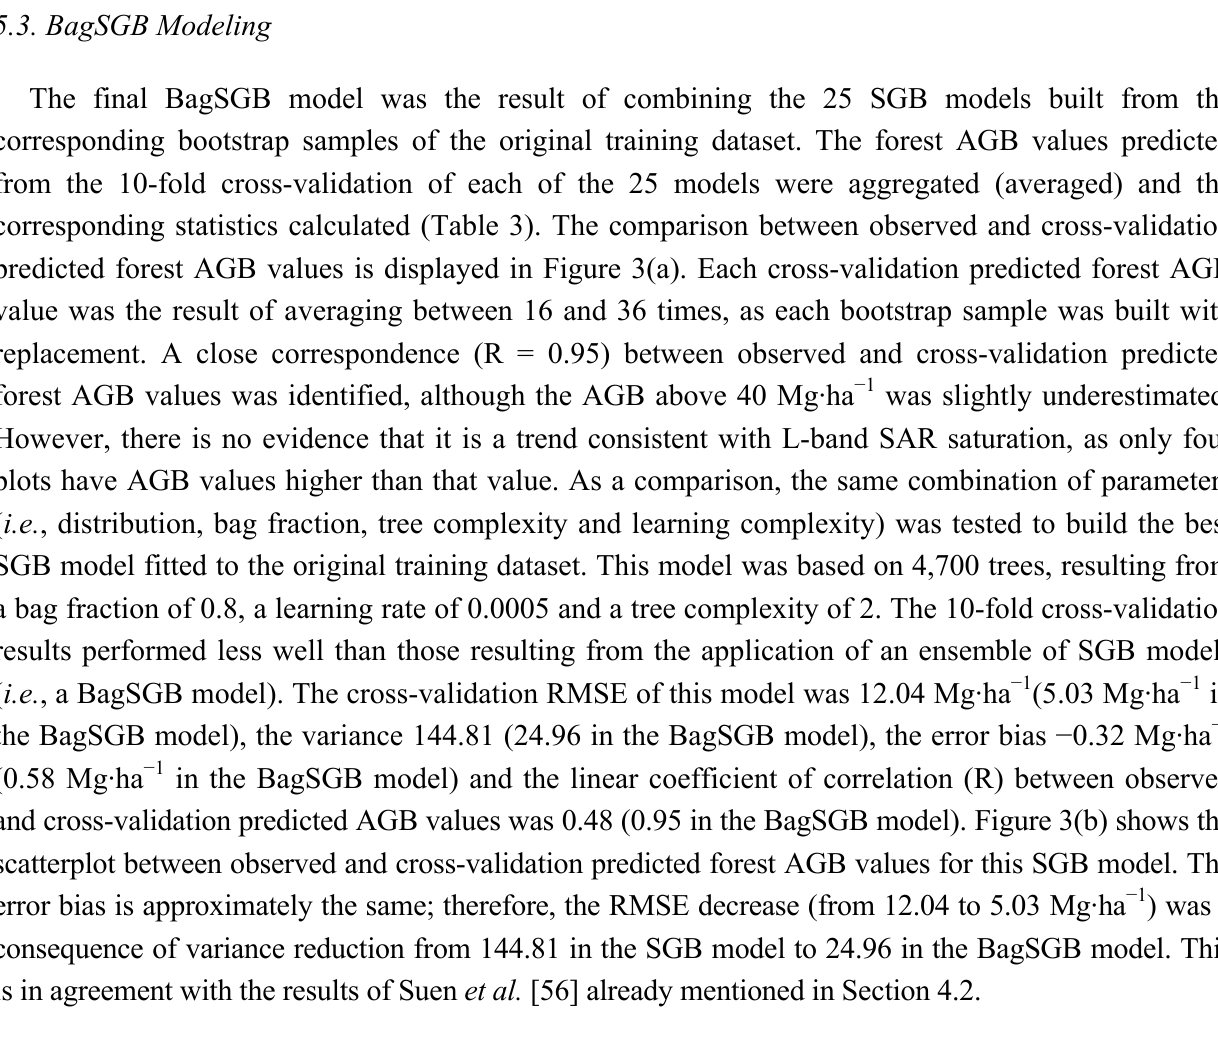
Table 3. Cross validation (10-fold) statistics for the fitted BagSGB and stochastic gradient boosting (SGB) models of forest AGB as a function of ALOS PALSAR FBD data. RMSE